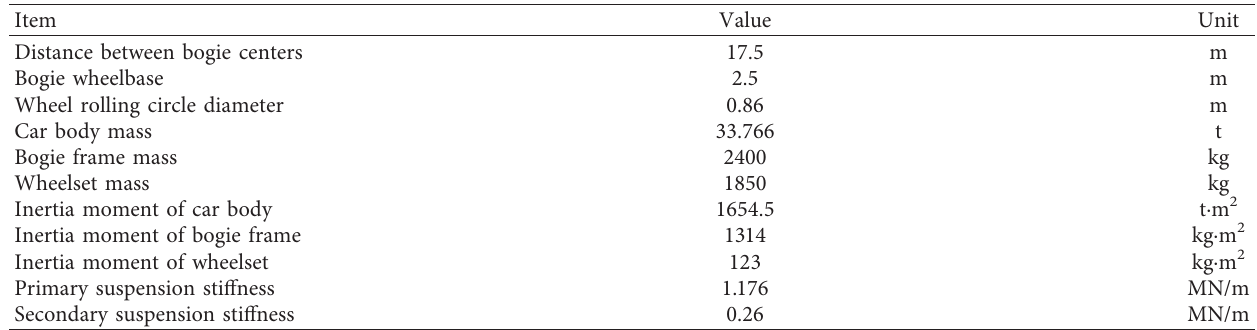
Figure 7: Additional static tensile stress at different locations subject to pier settlement: (a) slab and (b) Table 2: Parameters of the train.